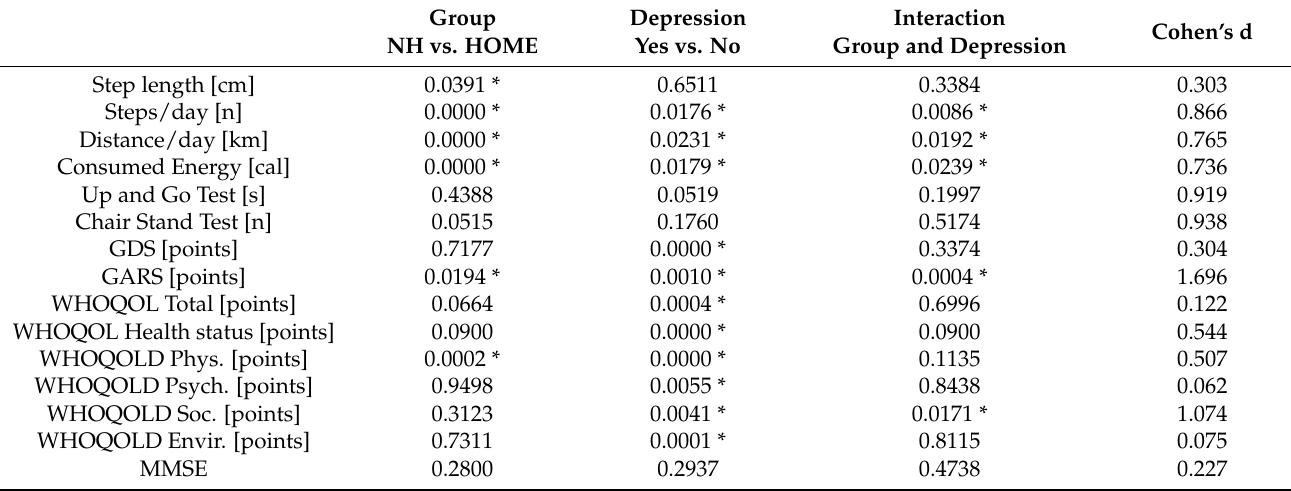
Table 5. Two-way ANOVA analysis of variance taking into account the place of residence of the respondents and the presence of